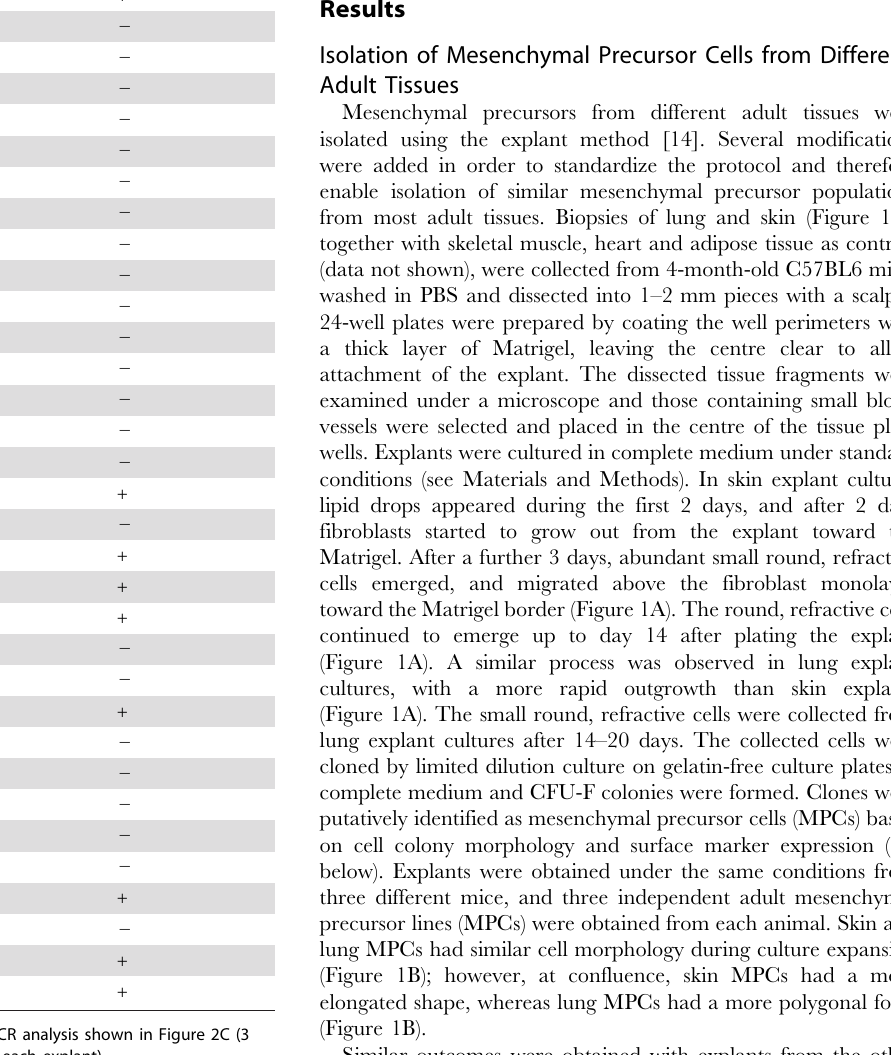
Table 3. Gene expression profile of skin and lung MPCs.